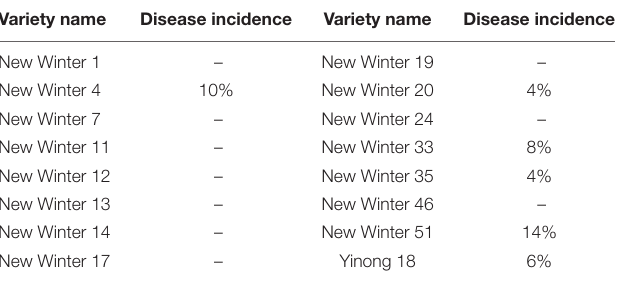
TABLE 2 | Seed dressing with difenoconazole application against T. controversa infected and non-infected wheat rhizosphere. Fungicide